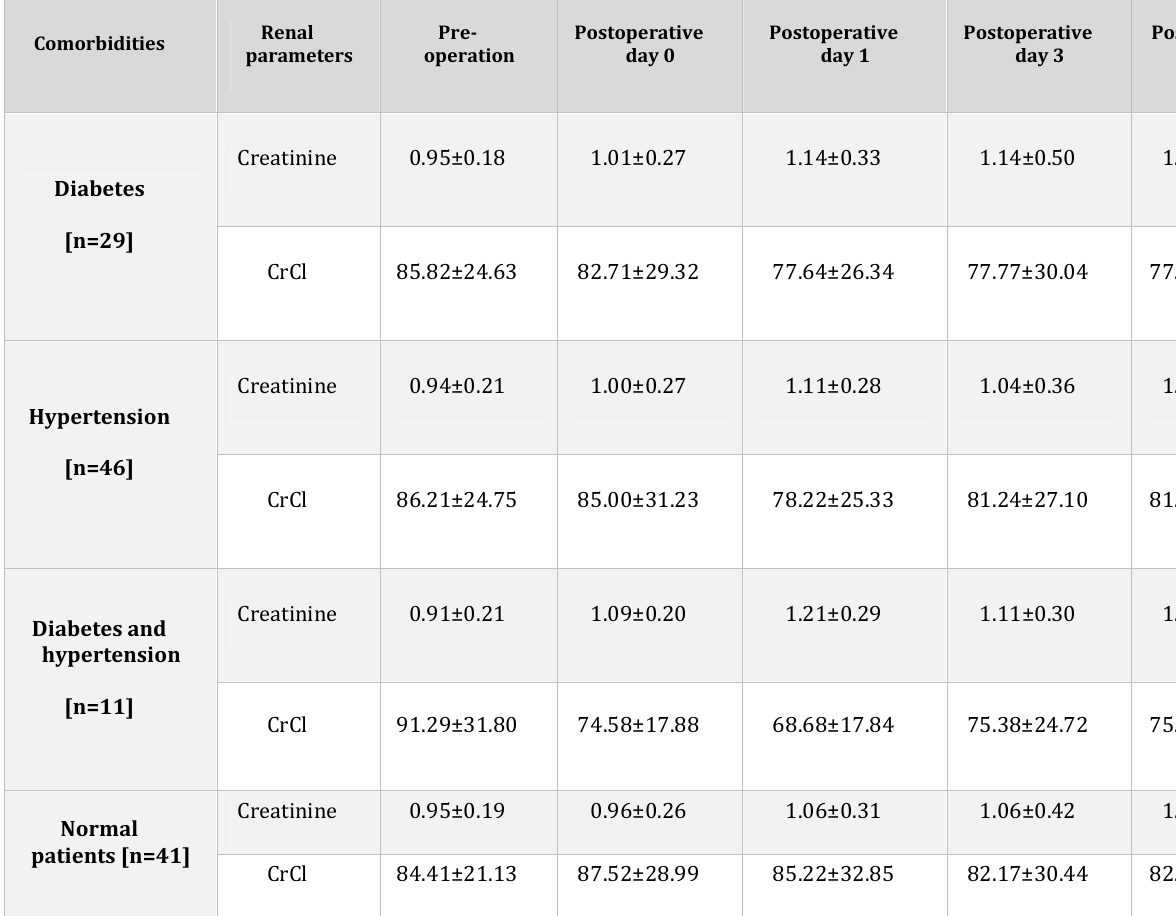
Table 3. Comparing preoperative and postoperative Creatinine and creatinine clearance [CrCl] of patients with diabetes, hypertension, both diabetes and hypertension, and normal patients in off-pump group Comorbidities